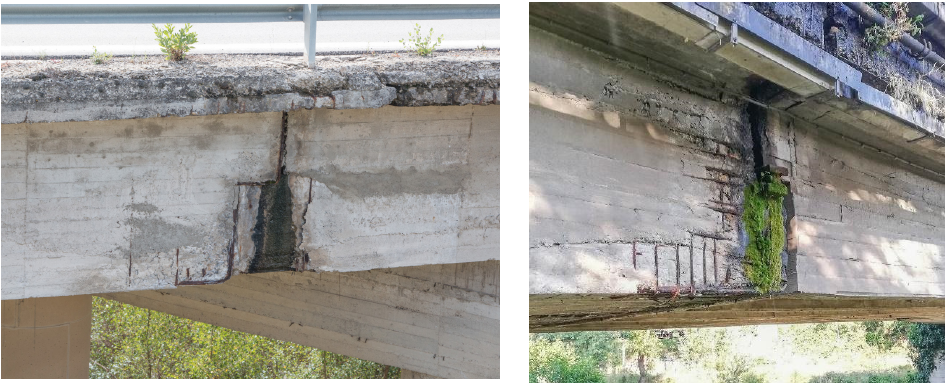
Figure 1. Examples of deteriorated Gerber saddles in RC road bridges.